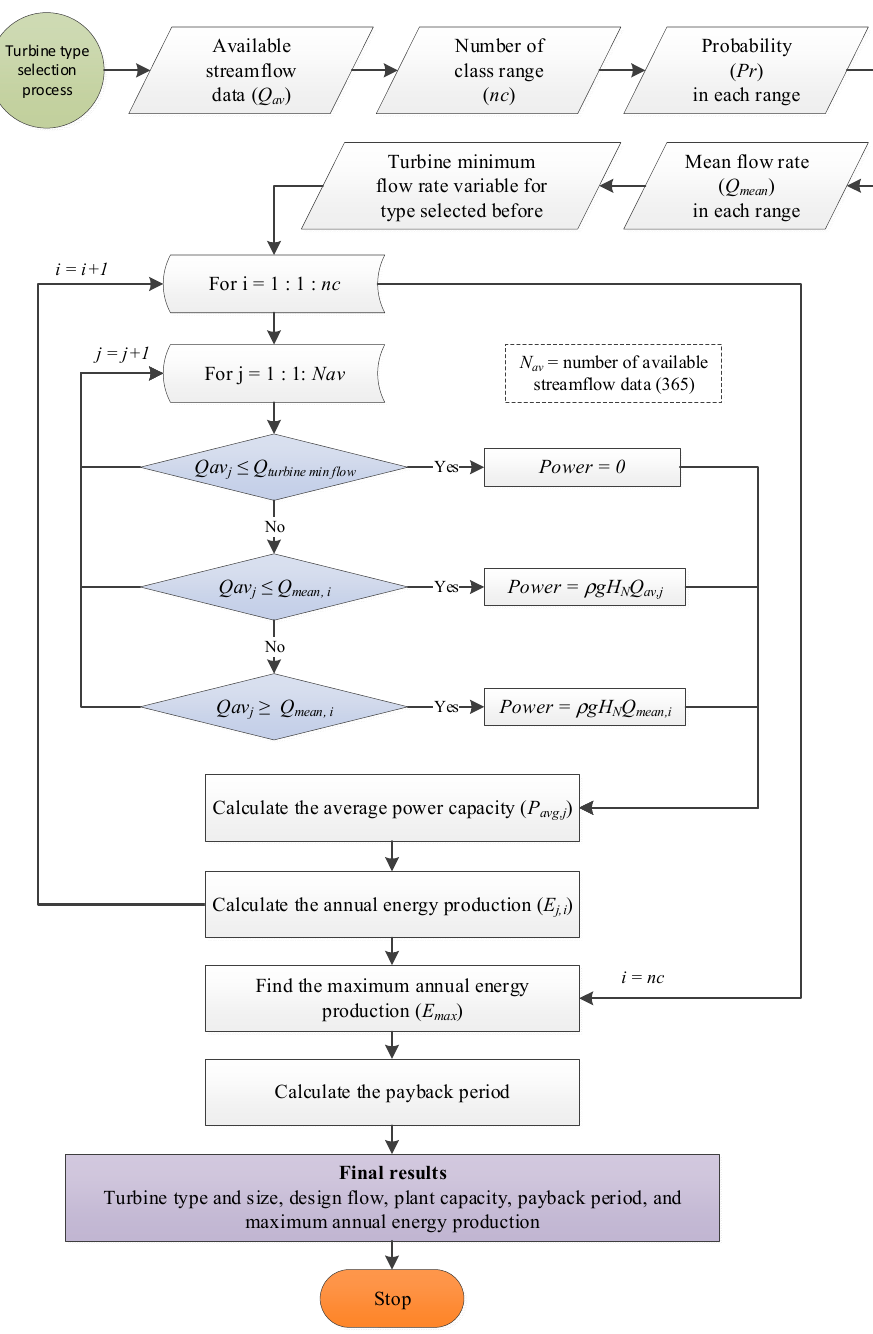
Figure 9. Optimal turbine size selection algorithm.